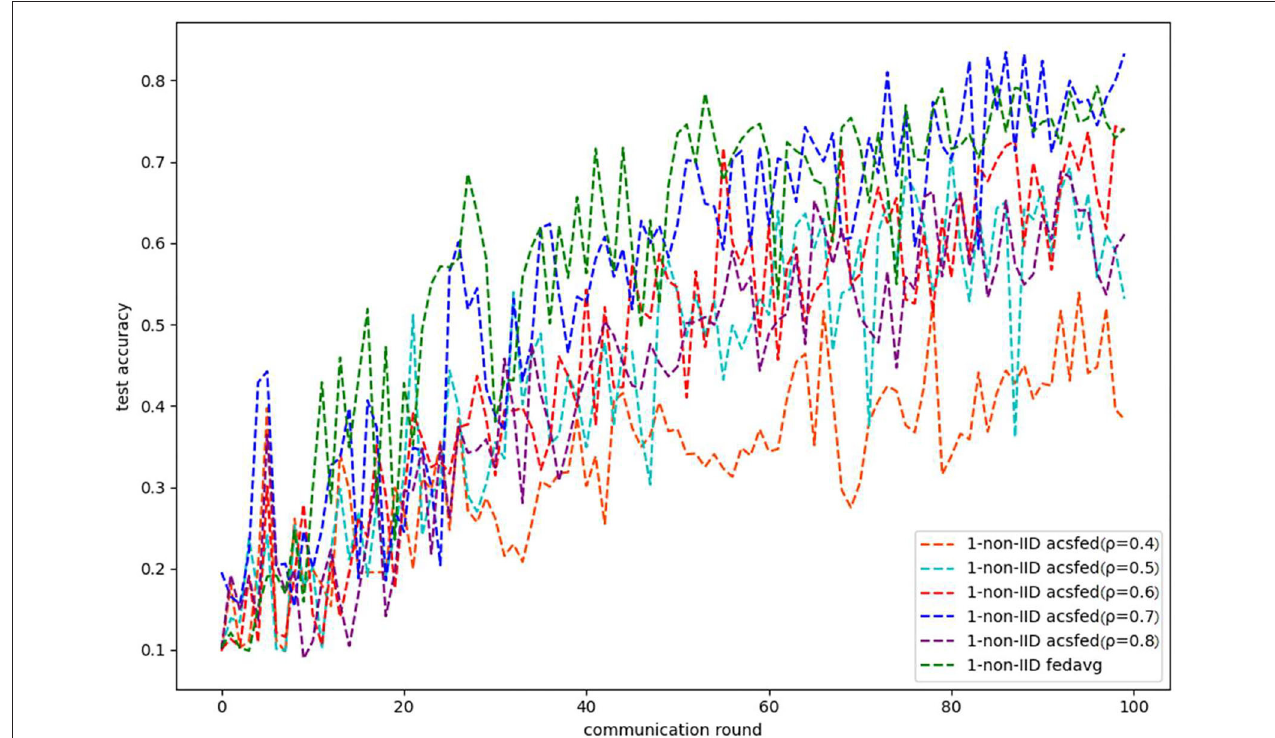
FIGURE 4 | Test accuracy on MNIST in the 1-class non-IID scenario.